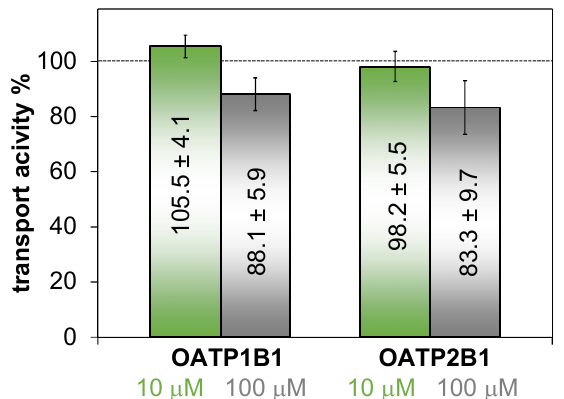
Figure 10. Effect of HQNO 2 -L-Pro on OATP1B1 and OATP2B1 activity. Uptake of disulfopyranine (OATP1B1) and pyranine (OATP2B1) was determined in A431 cells overexpressing these transporters and mock controls, in the absence (100%) or presence of 10 or 100 μM HQNO 2 -L-Pro. OATP-dependent transport was calculated by extracting fluorescence measured in mock transfected cells, and the activity measured in the absence of the tested compound set to 100%. Average (n = 3) ± SD values are shown.